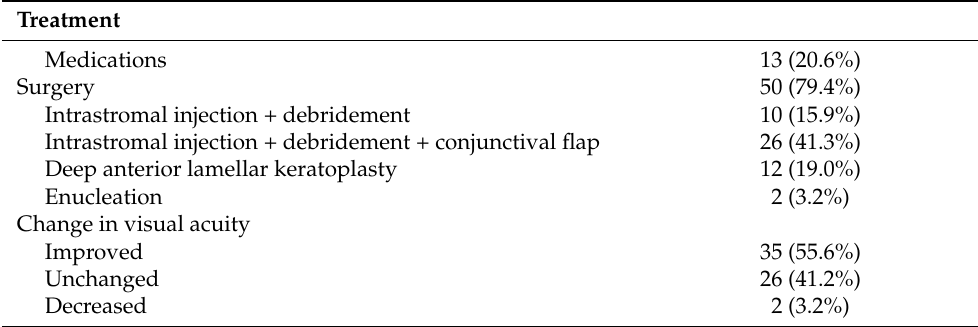
Table 3. Analysis of treatment modalities and changes in visual acuity in culture-positive patients ( n =